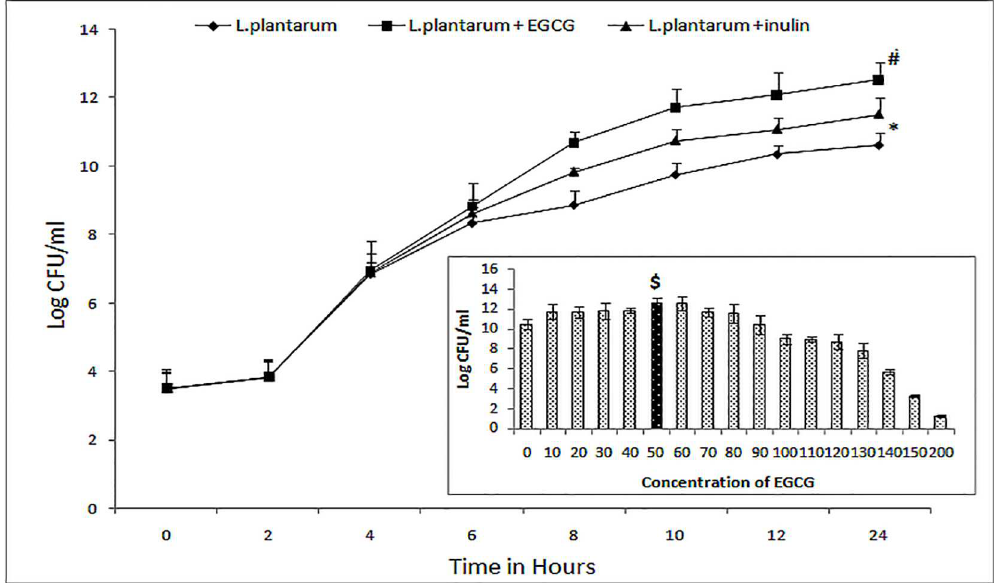
Fig 2. Comparative effect of EGCG and inulin on the growth of L . plantarum . Inset-Enhancingeffect of various doses of EGCG on the growth of L . plantarum . Values are expressedas mean ± standard deviationof three